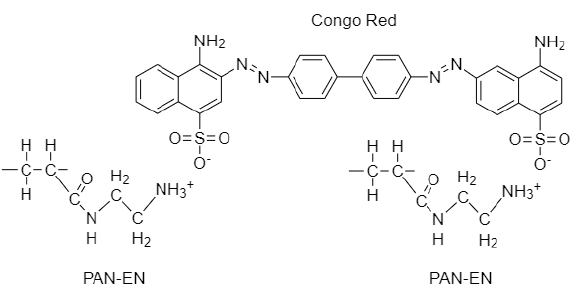
Figure 9. Electrostatic interaction between CR and PAN-EN membrane.